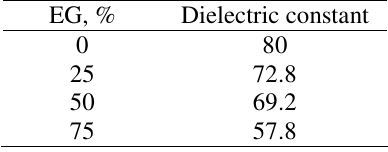
Table 2. Variation of dielectric constant as a function of solution composition